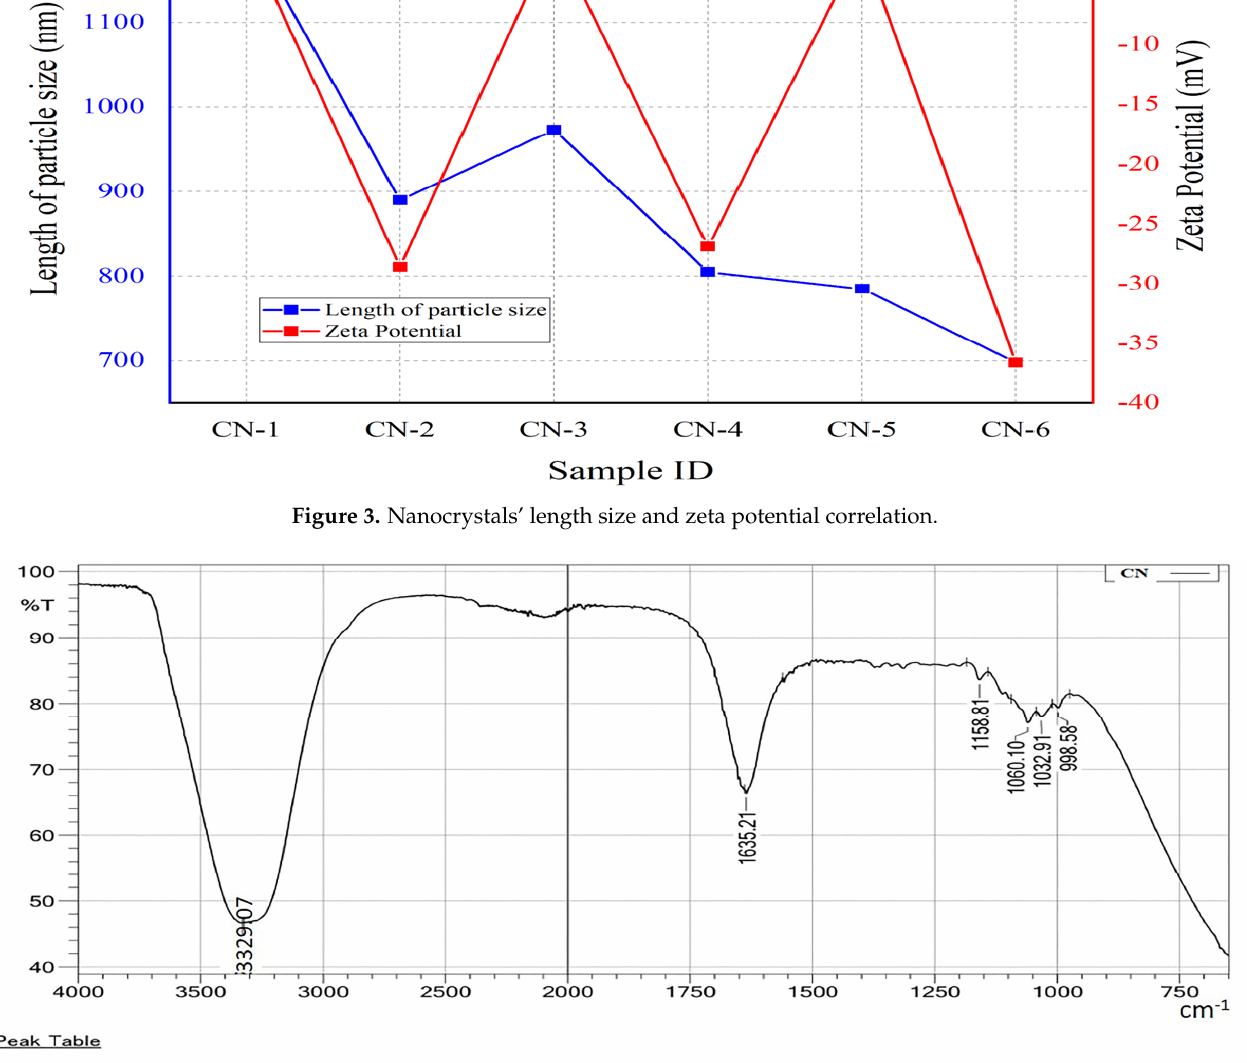
Figure 4. A detailed FTIR spectrum of CN-3, representing the absorption spectra of different groups.